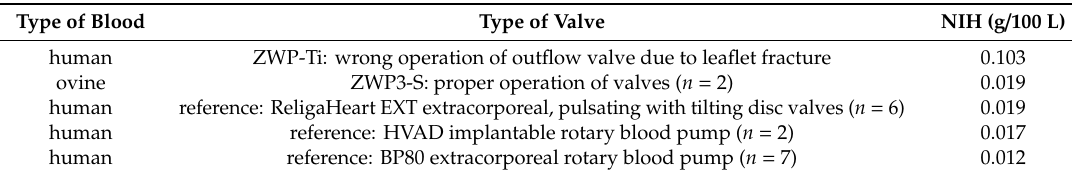
Table 1. Comparison of hemolysis of pulse pumps with the tested valves and hemolysis of reference pumps. Type of Blood Type of Valve NIH (g / 100 L) human ZWP-Ti: wrong operation of outflow valve due to leaflet fracture 0.103 ovine ZWP3-S: proper operation of valves ( n = 2) 0.019 human